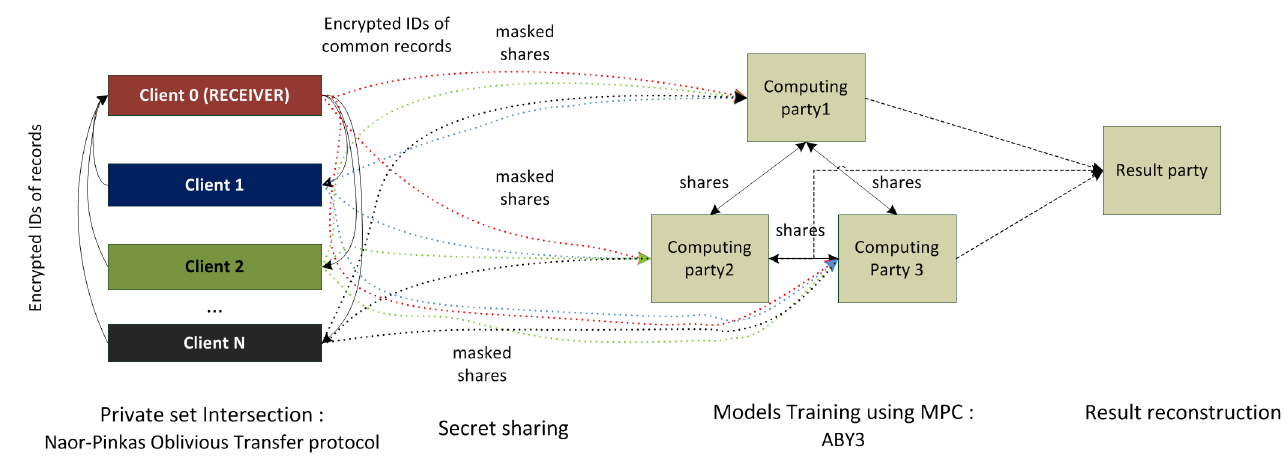
Figure 10. Analysis pipeline using MPC protocols implemented in the PFL